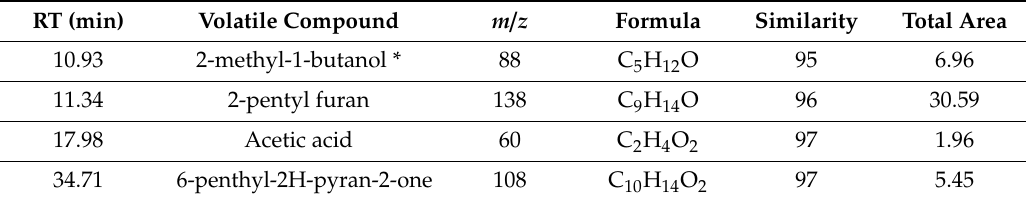
Table 3. International Union of Pure and Applied Chemistry (IUPAC) names of the volatile compounds produced by T. asperelloides PSU-P1 identified through SPME GC / MS analysis. RT (min)